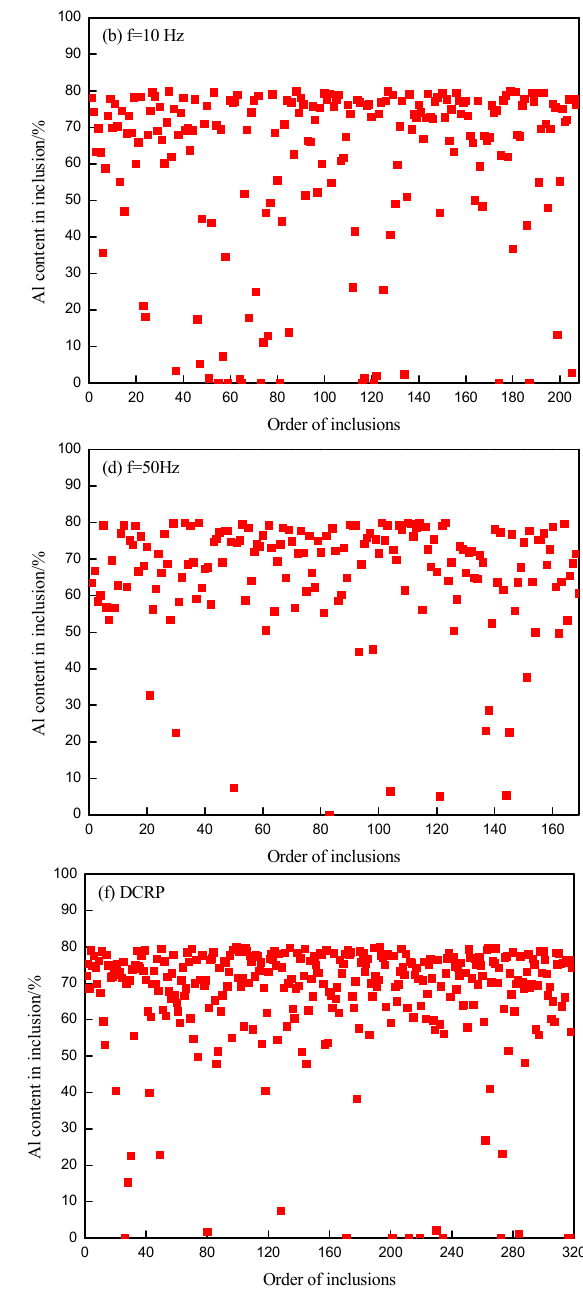
Figure 7. Compositon of other composite oxide inclusions in ESR ingot.